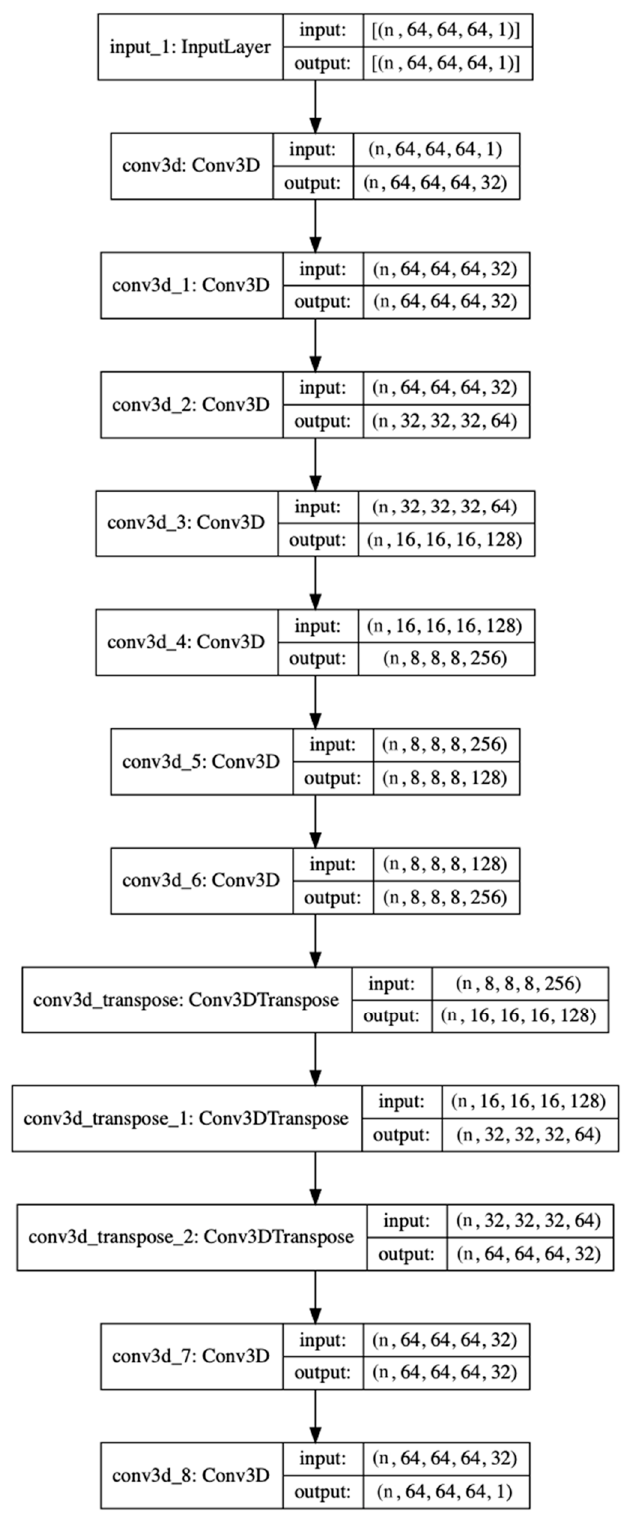
Figure 1. The structure of the autoencoder, which consists of nine 3D convolution layers and three 3D convolution_transpose layers, generates compressed images with sizes of (8, 8, 8, 128). N is the number of input data.